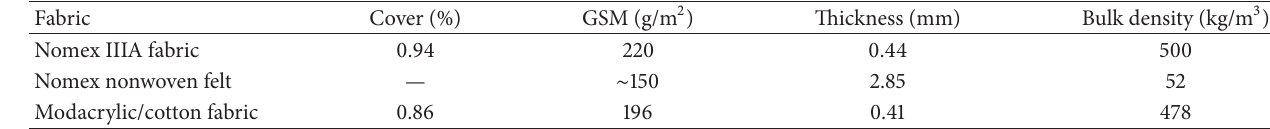
Table 1: Details of the fabrics used for making three layered assembly for